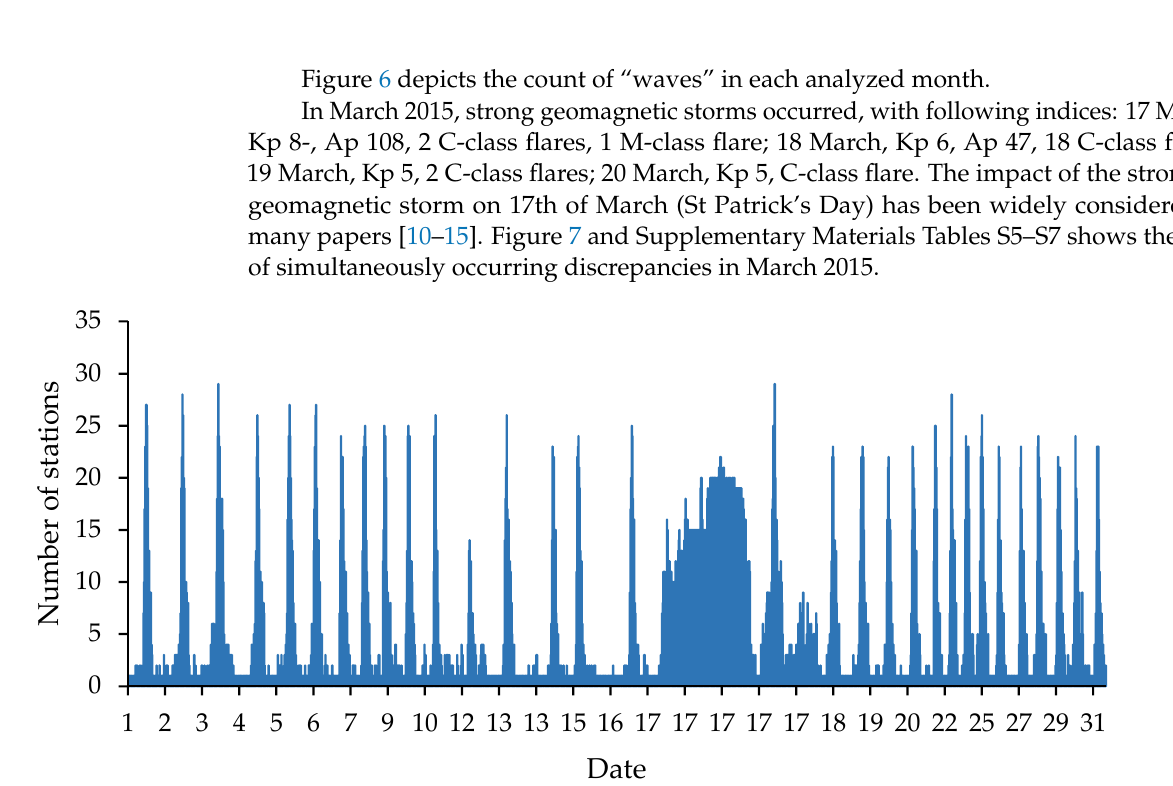
Figure 6. Count of “evil waves” in the selected month in period 2007–2017.